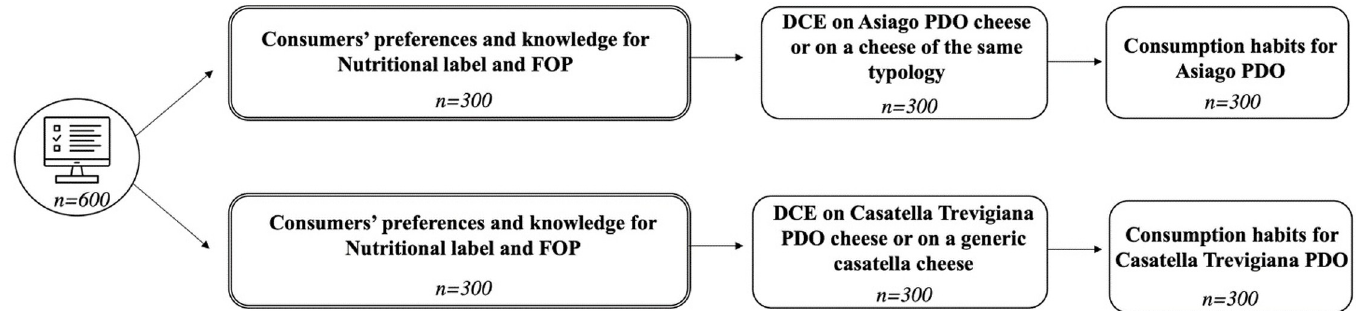
Fig 1. Structure of the experiment. Note . The experimental structure is the same in the two blocks. Differences are only found in the product subject of investigation (single line squares). Source . Our elaboration.